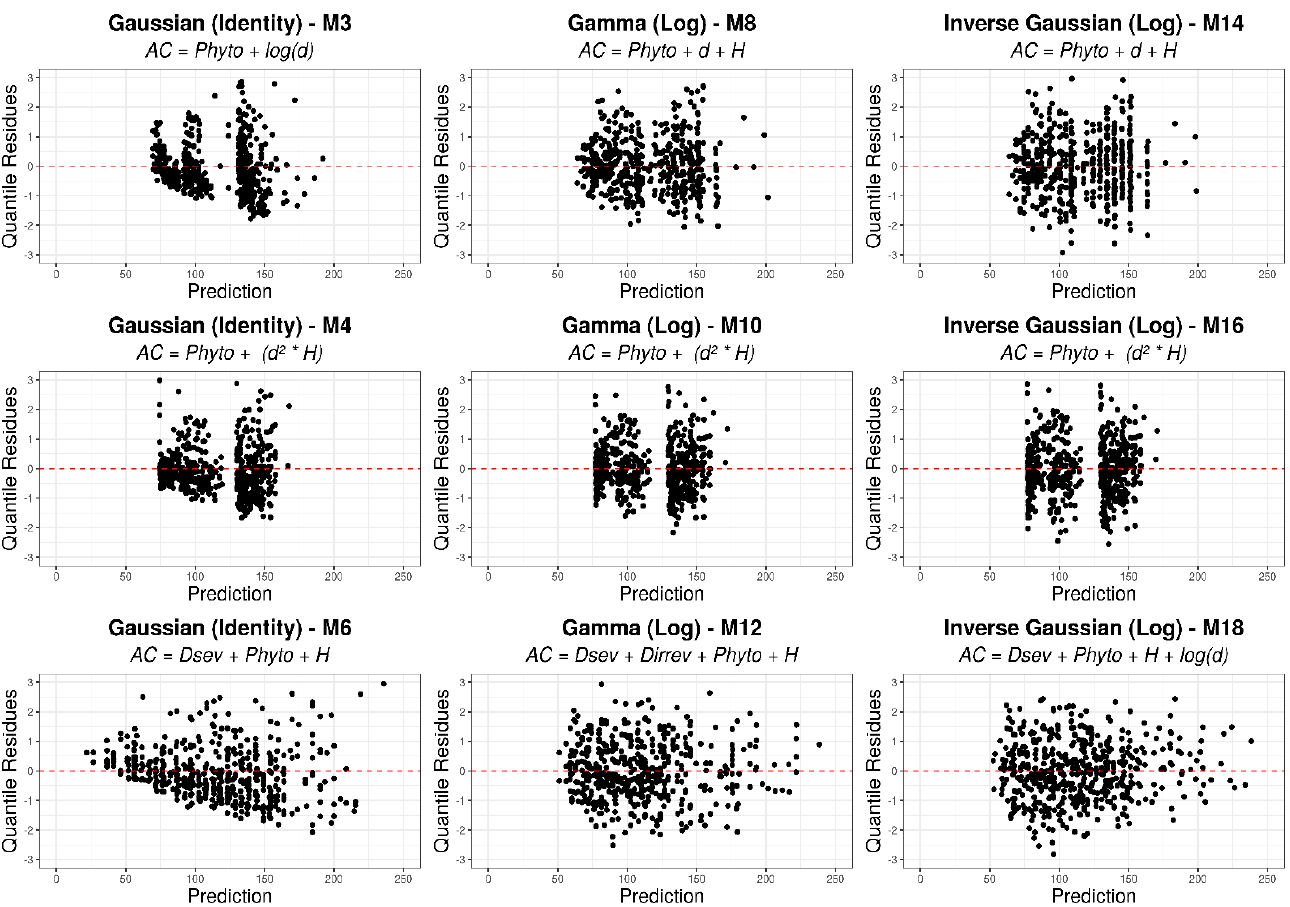
Figure 5. Half-normal plots with simulated envelope for the deviation residuals of the six models with the best fi tt ing. Predictors indicative of the amount of irreversible or severe damage to trees were more important in describing the e ff ects on the response variable. For the M12 model, the half- normal plots showed residuals inside the simulated enve-lope, indicating a good fi t of the model to the data. AC = area of the clearing; Phyto = phytophysiognomy; d = diameter at breast height; H = height; Dirrev = number of trees with irreversible damage; Dsev = number of trees with severe dam- age; log = logarithmic transformation.